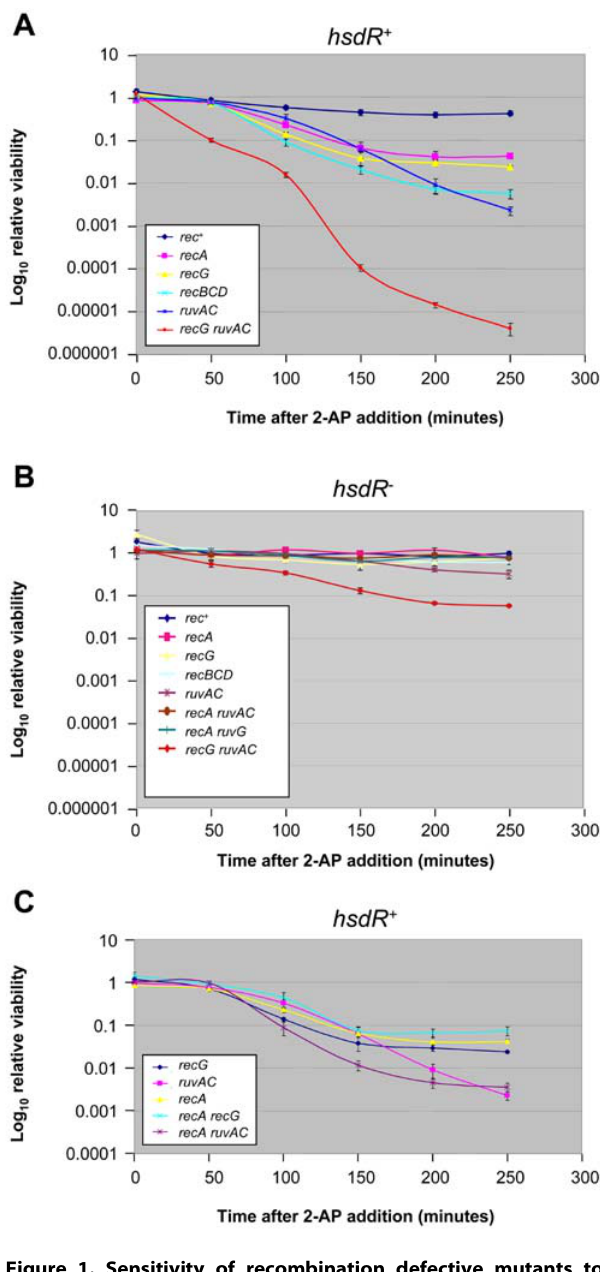
Figure 1. Sensitivity of recombination defective mutants to EcoKI breaks. Exponential cultures were treated with 20 m g/ml of 2-AP and relative viability calculated as described in Experimental Procedures. Error bars indicate 95% confidence intervals. (A) Indicated genotypes are in an hsdR + D clpX background. The strains used were DL1902 ( rec + ), DL2656 ( recA ), DL1940 ( D recG ), DL2659 ( D recBCD ), DL1938 ( D ruvABC ), DL 1962 ( D recG D ruvABC ). (B) Indicated genotypes are in an hsdR514 D clpX background. The strains used were DL1800 ( rec + ), DL2666 ( recA ), DL2133 ( D recG ), DL2675 ( D recBCD ), DL2114 ( D ruvABC ), DL2667 ( recA D ruvABC ), DL2671 ( recA D recG ), DL2676 ( D recBCD D ruvABC ), DL2674 ( D